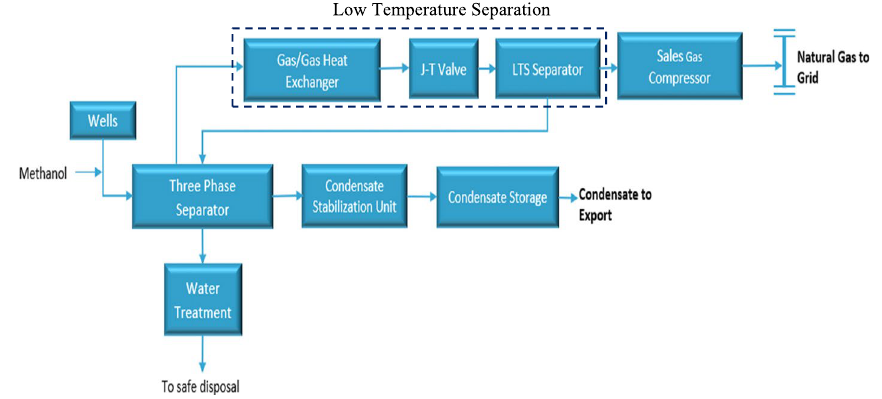
Fig. 1 Gas plant block flow diagram